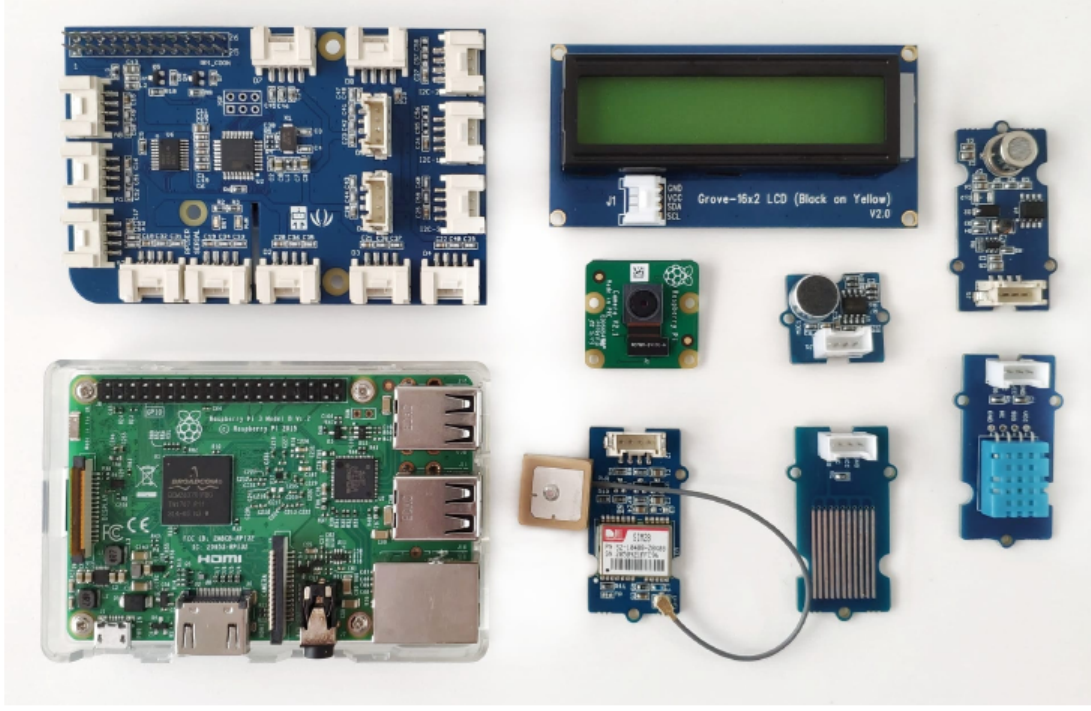
Figure 3. Electronic components to create an